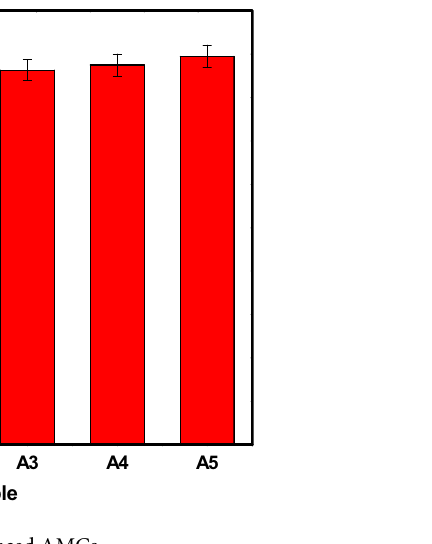
Figure 9. Hardness value for the produced